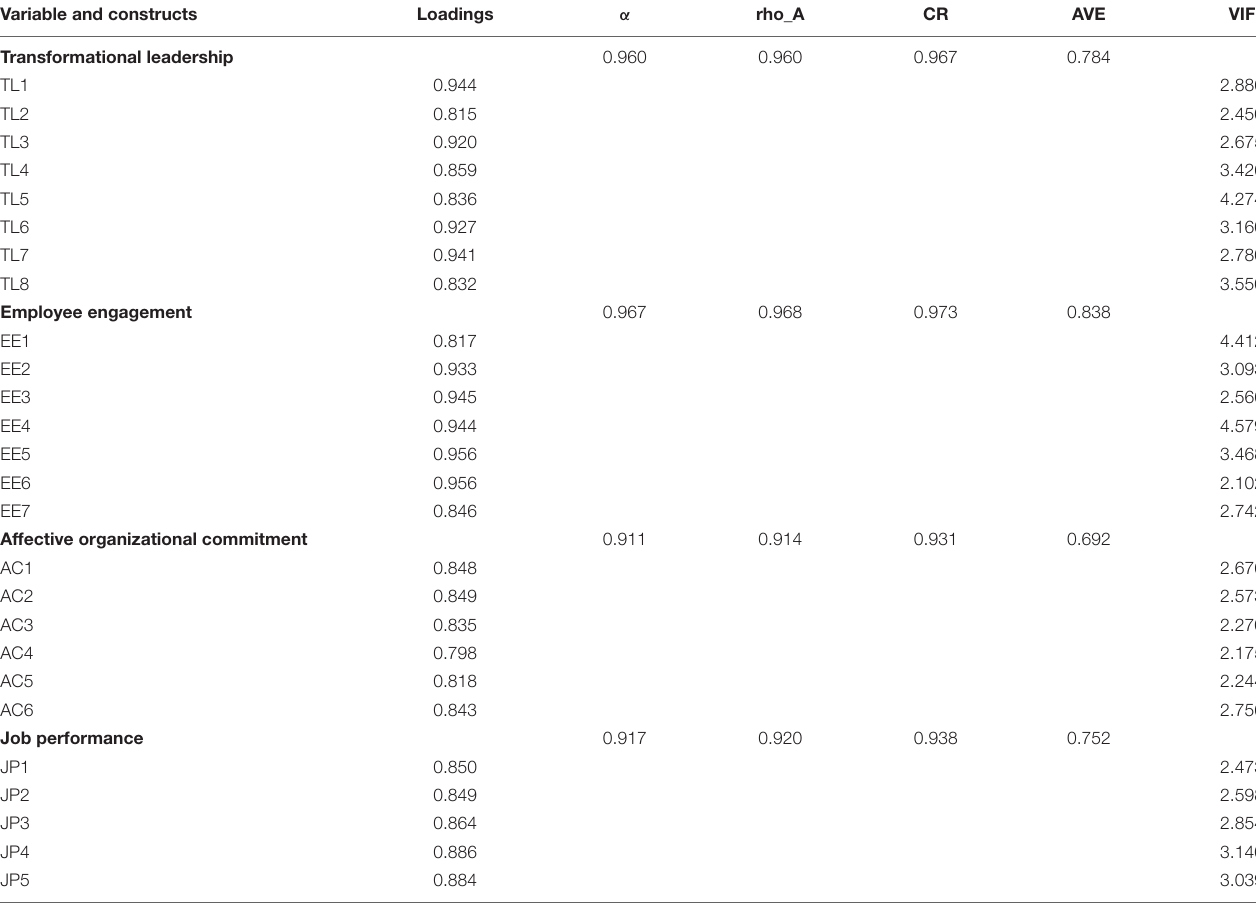
TABLE 1 | Measurement model.